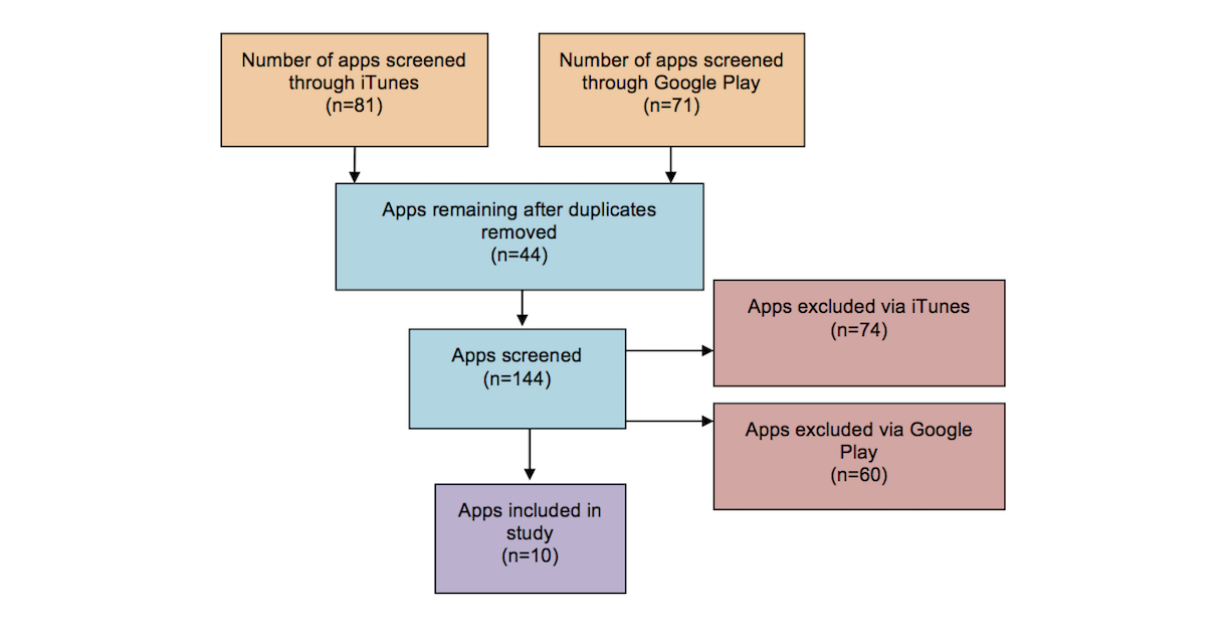
Figure 1. App selection process. The number of apps screened is the number of apps that had to be screened before identifying five apps for each database that fit the inclusion criteria. Eight apps were duplicated across both databases; therefore 144 apps were screened before the final ten were